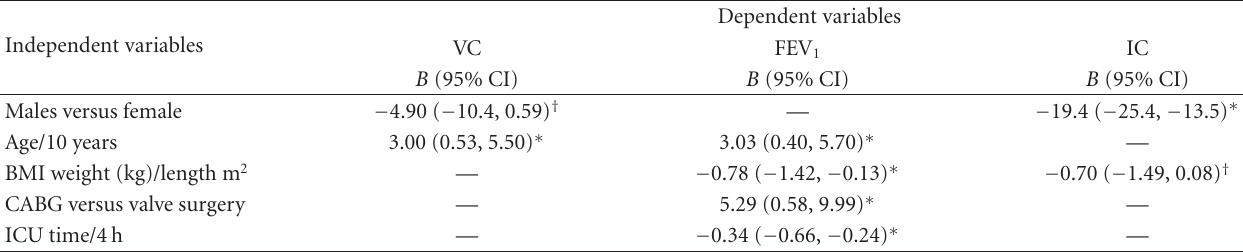
Table 2: The variables associated with postoperative lung volumes (expressed as percent of predicted values), ( n = 107). Univariate analyses. Independent variables